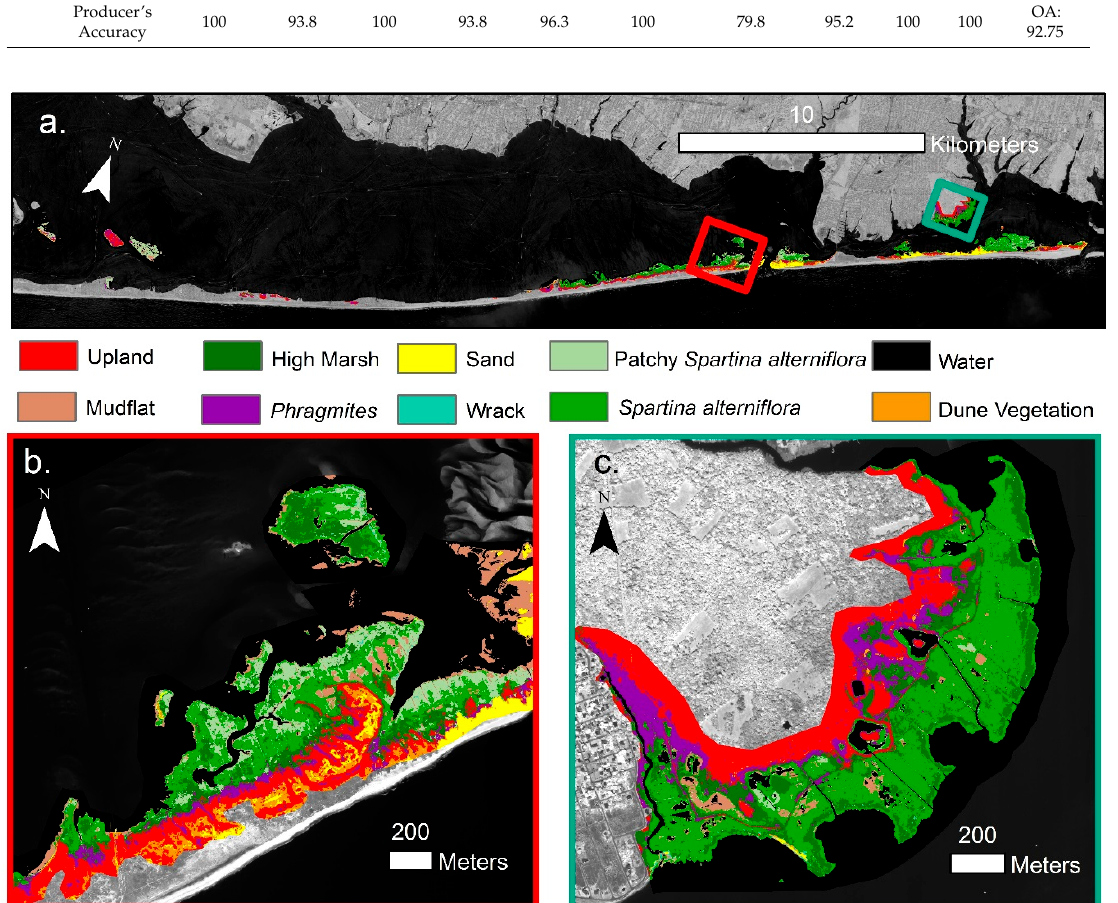
Table 2: An error matrix for the 2015 Worldview-2/Worldview-3 classification of Fire Island National